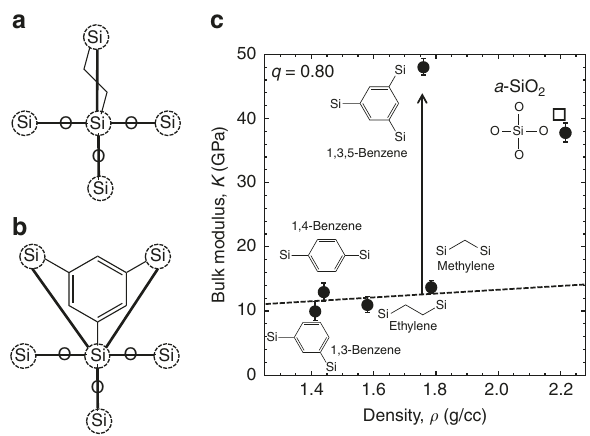
Fig. 1 Molecular dynamics simulations predict that hyperconnected glasses have exceptional elastic stiffness. Fully condensed silicon atoms (the condensation degree is q = 1.0) have network connectives of m Si = 4 and m = 5 for ( a ) ethylene-bridged glasses and ( b ) 1,3,5-benzene glasses, Si respectively. c The predicted bulk modulus, K , as a function of the predicted mass density, ρ , for model organosilicate glasses with various organic bridges: ethylene, methylene, 1,4-benzene, 1,3-benzene, and 1,3,5-benzene. The 1,3,5-benzene hyperconnected glasses have a higher stiffness but signi fi cantly less density than the experimental value for amorphous SiO 2 (plotted as the open square) 41 – 43 . The simulated value for a -SiO 2 shows good agreement with experiment. The error bars denote one standard deviation of the mean of three trials per